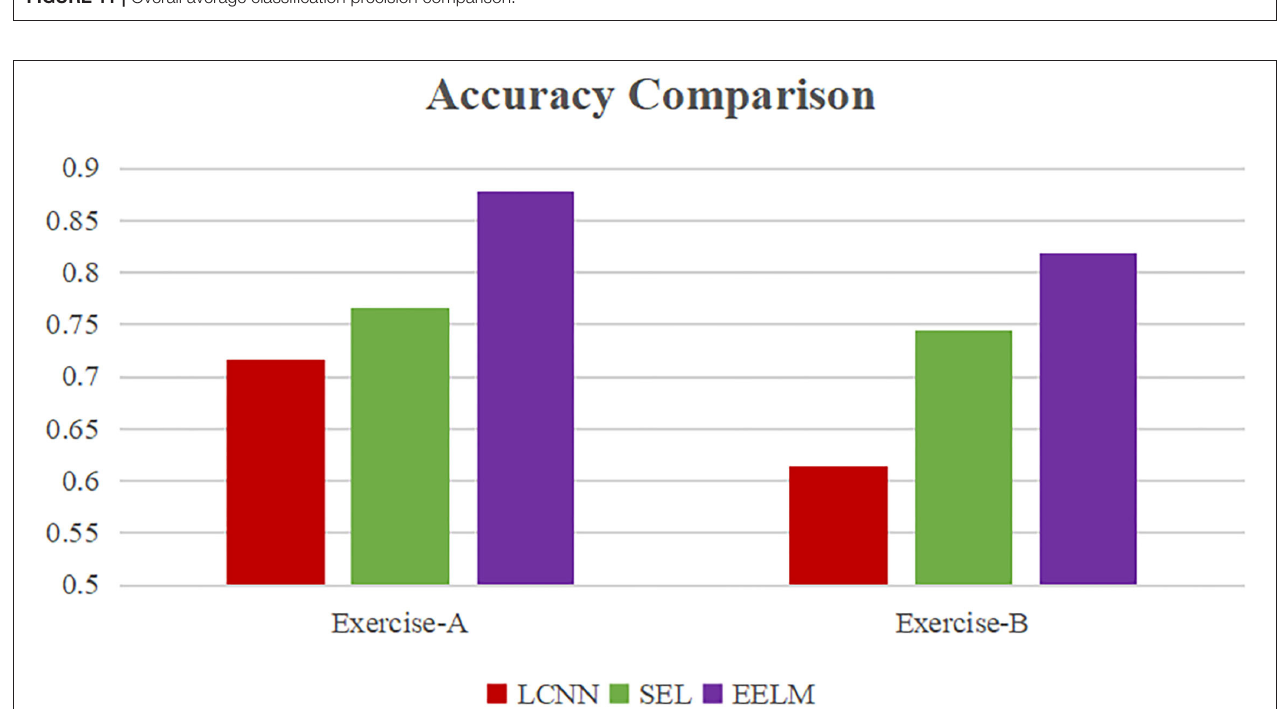
FIGURE 11 | Overall average classification precision comparison.